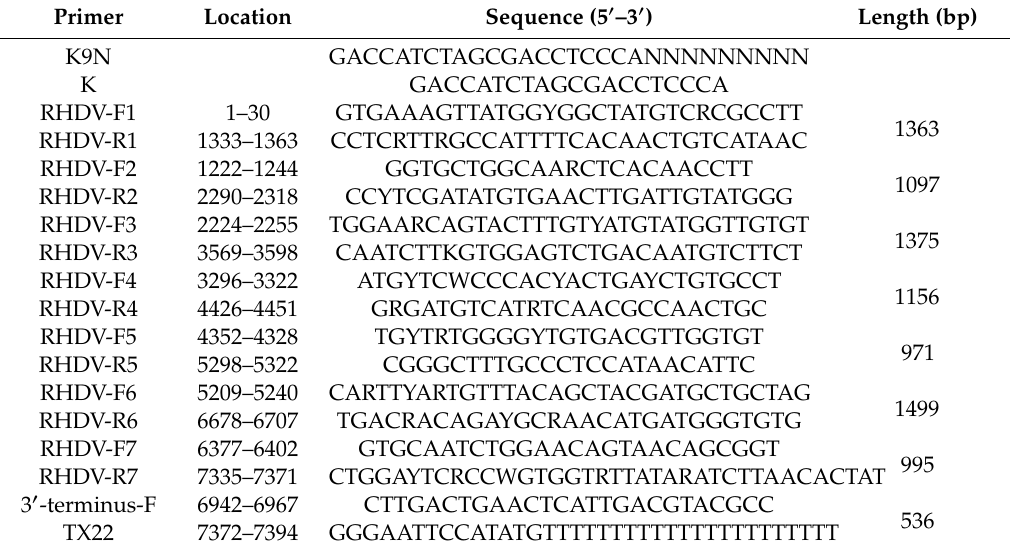
Table 1. Primers designed for detecting and amplifying the complete genome of rabbit hemorrhagic disease virus (RHDV) strain GS / YZ. Primer